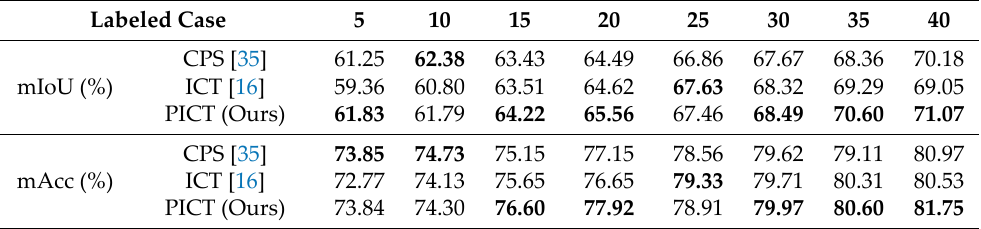
Figure 9. The mean DSC score point‑fold line of different methods on Multi‑tissue Pelvic dataset with different ratio labeled cases. Table 6. The mIoU (%) and mAcc for CPS, ICT, and PICT on Multi‑tissue Pelvic with different ratio labeled cases. The bold fonts indicate the best results of the comparing variants.